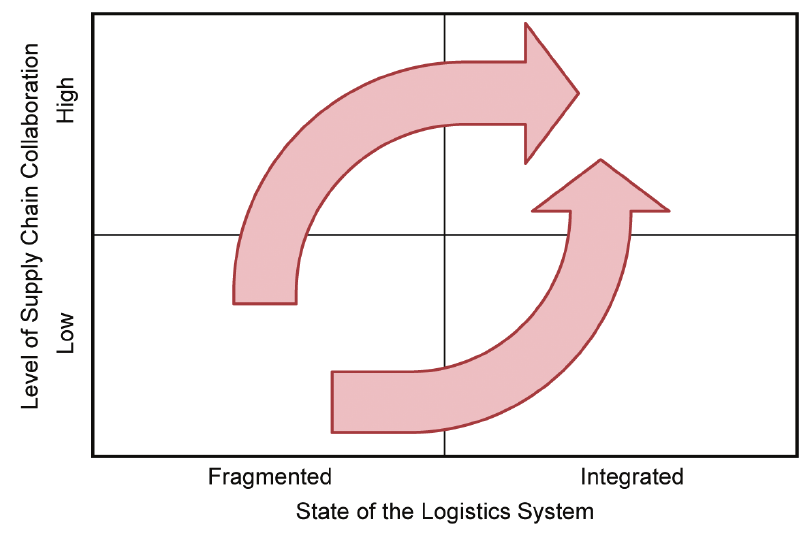
Figure 5: Drivers of competitive supply